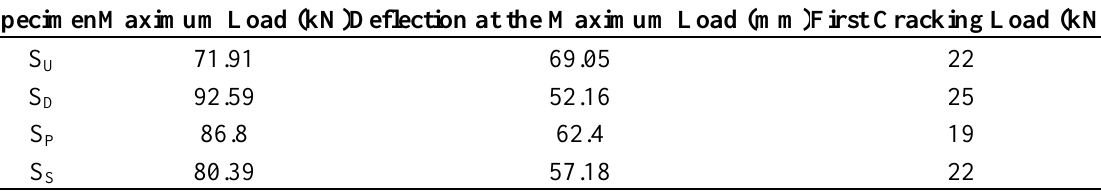
Table 2. Test results of loads and